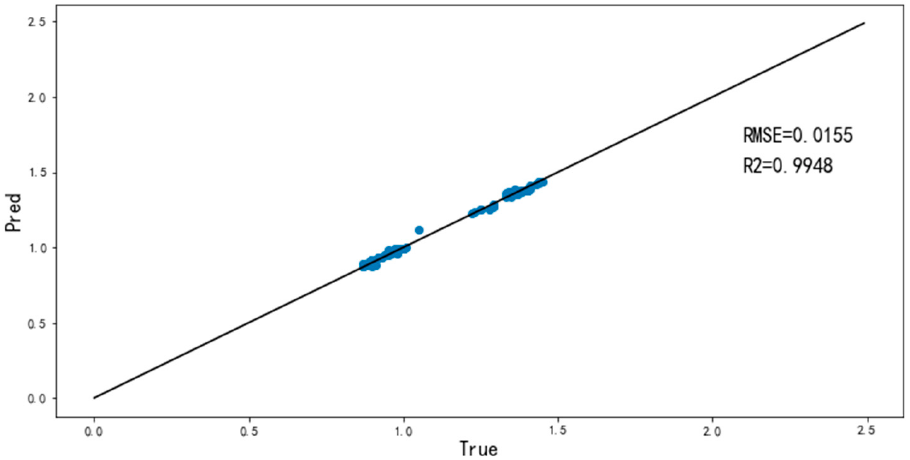
Figure 8. RMSE and R 2 of the training set.